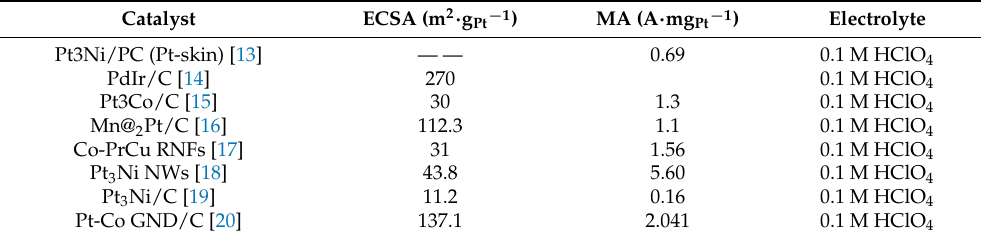
Figure 1. Volcanic distribution of ORR activity of Pt-based transition-metal alloys. Table 1. Summary of the electrochemical performances of recently reported alloy-related electrocata- lysts for the